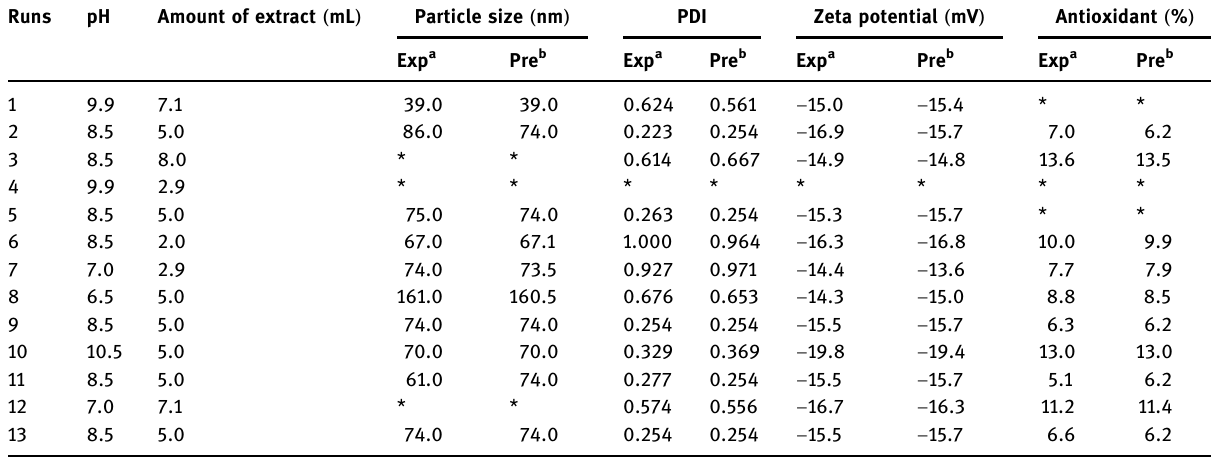
Table 1: CCD and values of response variables ( predicted and experimental ) for synthesis of Au NPs using A. urmiana extract Runs pH Amount of extract ( mL